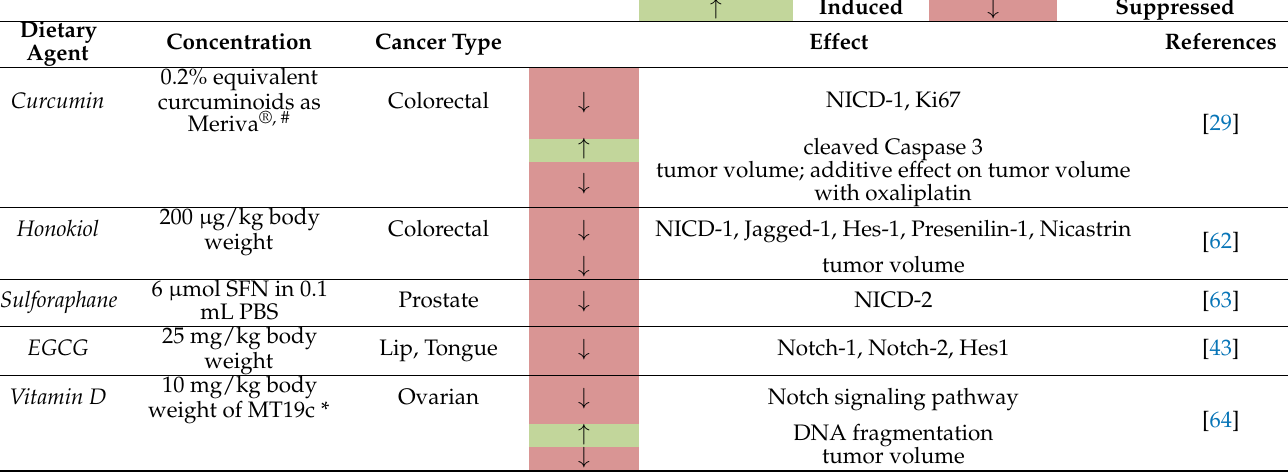
Table 2. Effect of dietary agents on Notch pathway components in vivo by cancer